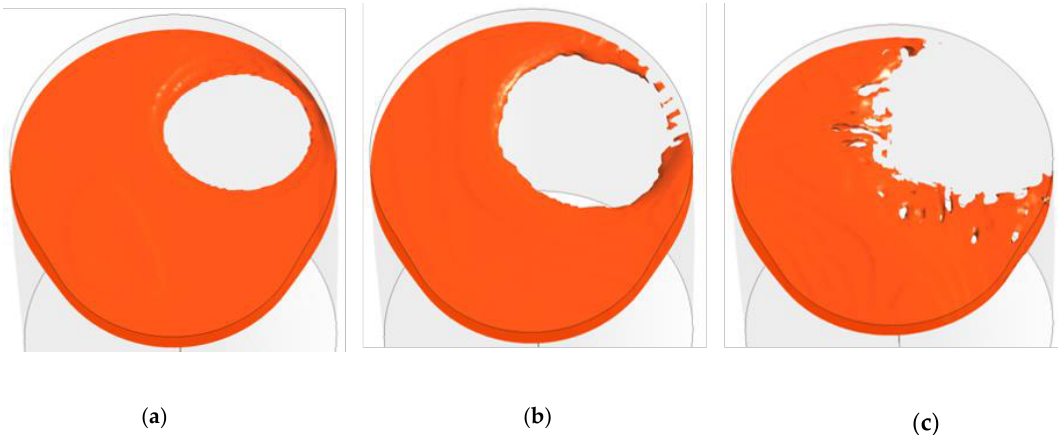
Figure 3. Open-eye size in the ladle from simulation results ( Z = 3.37 m): ( a ) Q = 100 NL/min, ( b ) Q = 300 NL/min, and ( c ) Q = 500 NL/min.